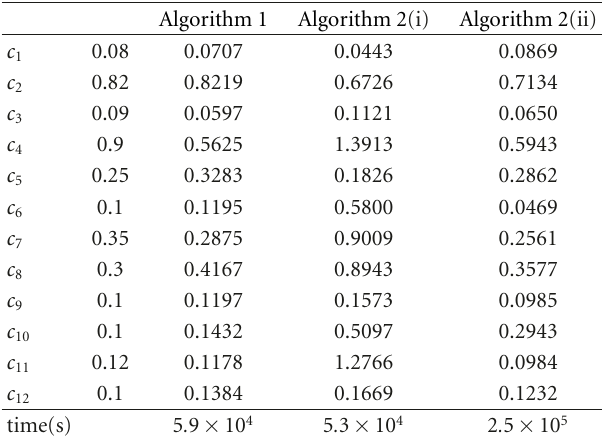
Table 1: True and estimated parameters for the two algo- rithms. Algorithm 2(i) employs 2 × 10 5 MCMC iterations, and Algorithm 2(ii) employs 10 6